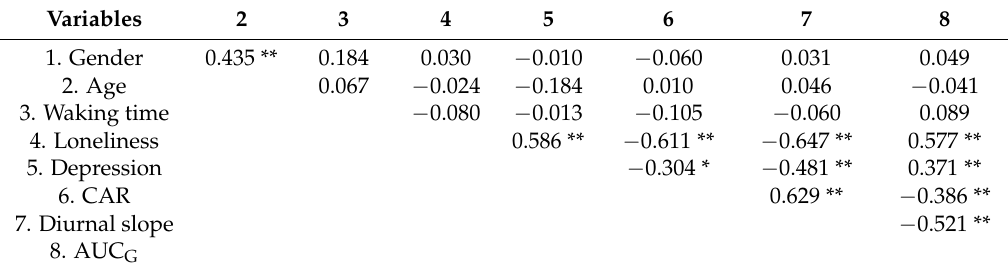
Table 2. Pearson correlations for loneliness, depression, mean cortisol indices, and